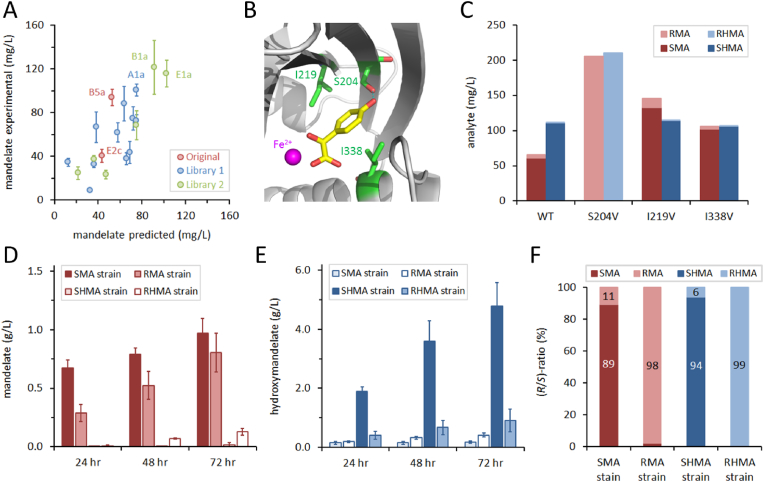
Optimization and scale-up of mandelic acid production. (A) Screening SyHMAS performance in different expression vectors. DoE was used to design a library of plasmids with different variables (replication origin, promoter and antibiotic resistance gene). This library (blue) was screened in DH5α cells along with two original plasmids (red; see Fig. 5). Analysis of mandelic acid titers after 24 h allowed modelling of predicted titers for different vector variables. A second library of 6 plasmids (green), predicted to include high, medium and low producers, was then constructed and screened. (B) Homology model of SyHMAS, showing the predicted position of hydroxymandelic acid (yellow sticks) and the catalytic Fe2+ ion. Residues targeted for mutagenesis are labelled in green. (C) Production of mandelic acid (red) and hydroxymandelic acid (blue) by selected SyHMAS mutants. Stacked bar heights represent the combined titer for each analyte, with the relative proportion of (R)- and (S)- enantiomers indicated (light and dark colors, respectively). (D) Mandelic acid titers for bioreactor cultures. Engineered E. coli strains hosting optimized mutant SyHMAS expression plasmids were cultured under conditions selected to favor production of the (R)- or (S)-enantiomers of mandelic acid (RMA & SMA) or hydroxymandelic acid (RHMA & SHMA). (E) Hydroxymandelic acid titers for bioreactor cultures described above. (F) Chiral analysis of mandelic acid (red) and hydroxymandelic acid (blue) produced by bioreactor cultures after 72 h. (For interpretation of the references to color in this figure legend, the reader is referred to the Web version of this article.)